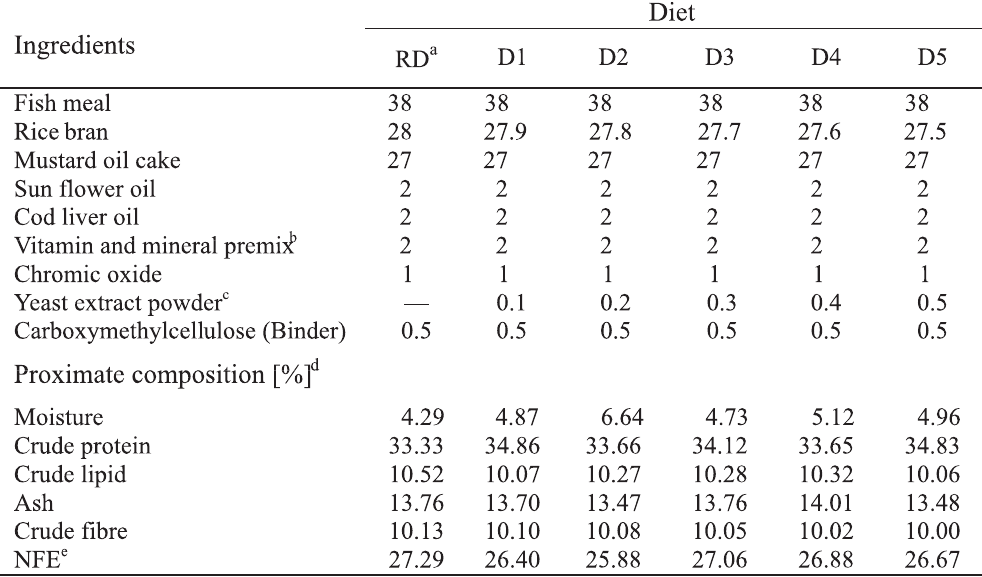
a Control diet; b vitamin and mineral premix (Vitaminets Forte, Nicholas Piramal India Ltd.,